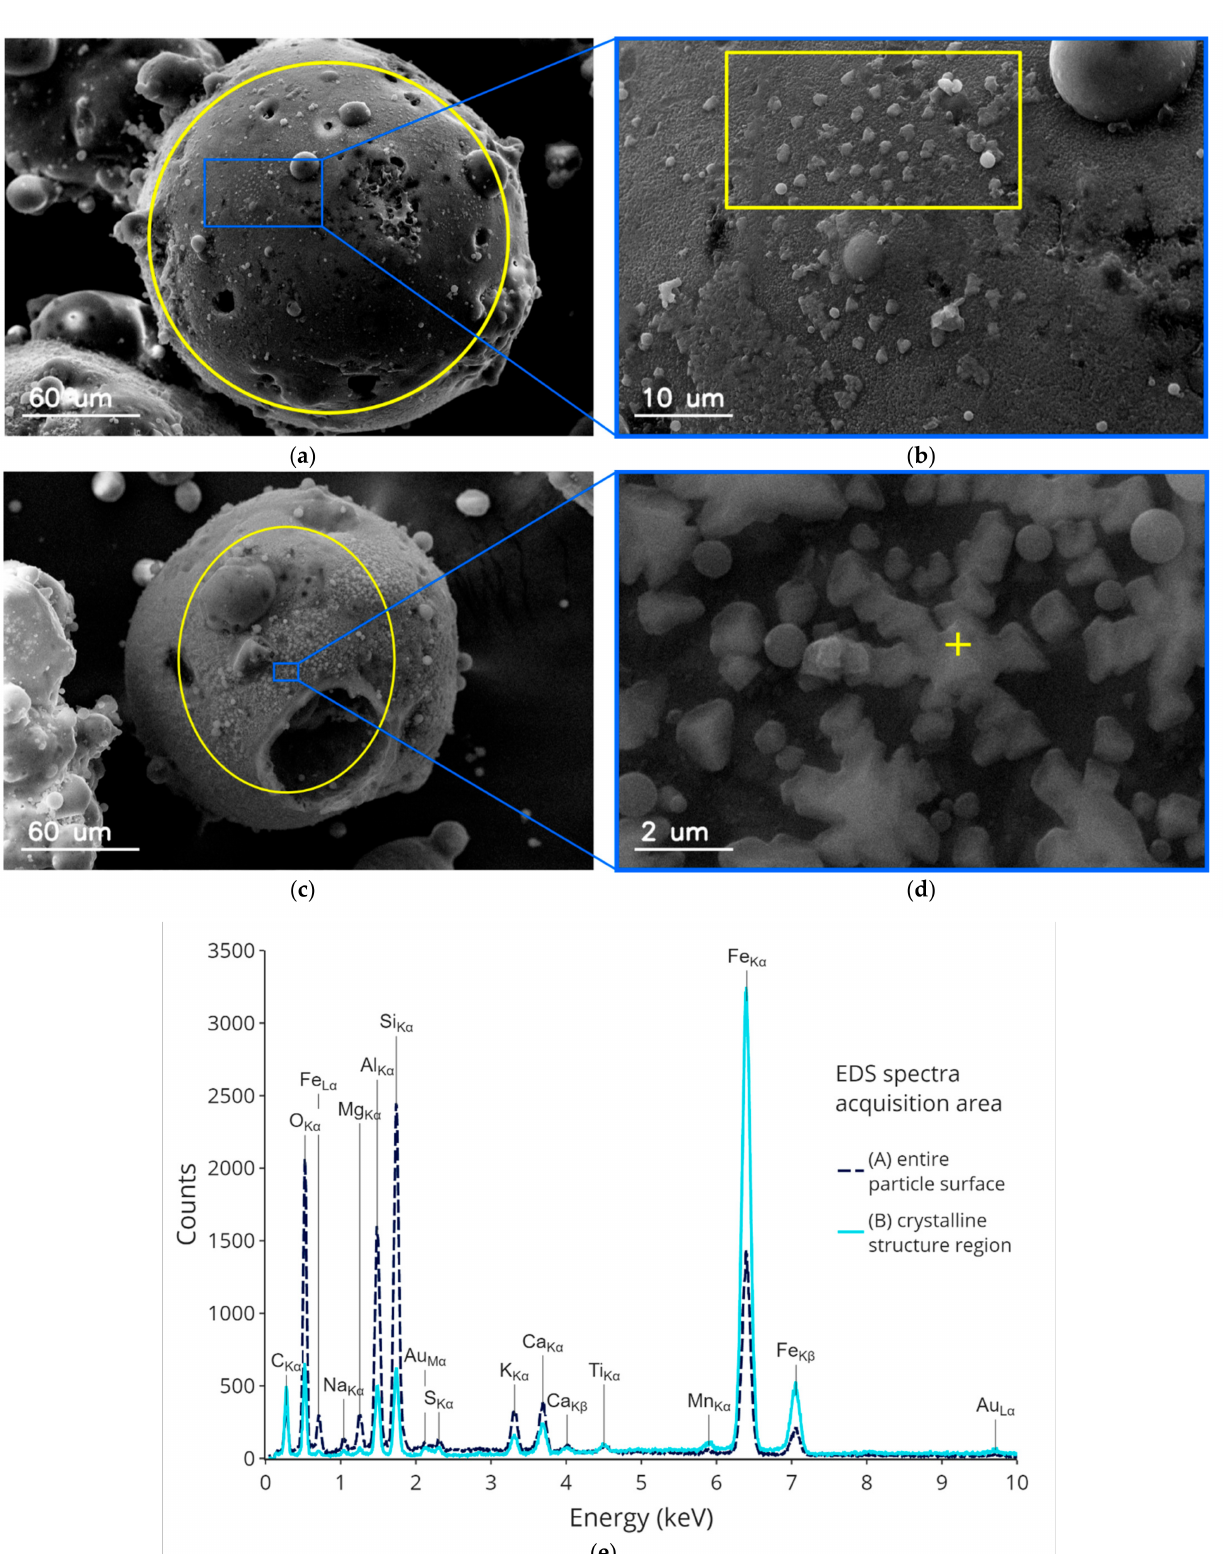
Figure 6. SEM micrographs of magnetic fly ash particles and its EDS spectra: ( a , c ) General views of the selected particles with marked area of EDS spectrum acquisition; ( b , d ) detailed views of crystalline structures visible on the ( a , c ) particles. respectively; ( e ) EDS spectra of particles shown in ( a , b